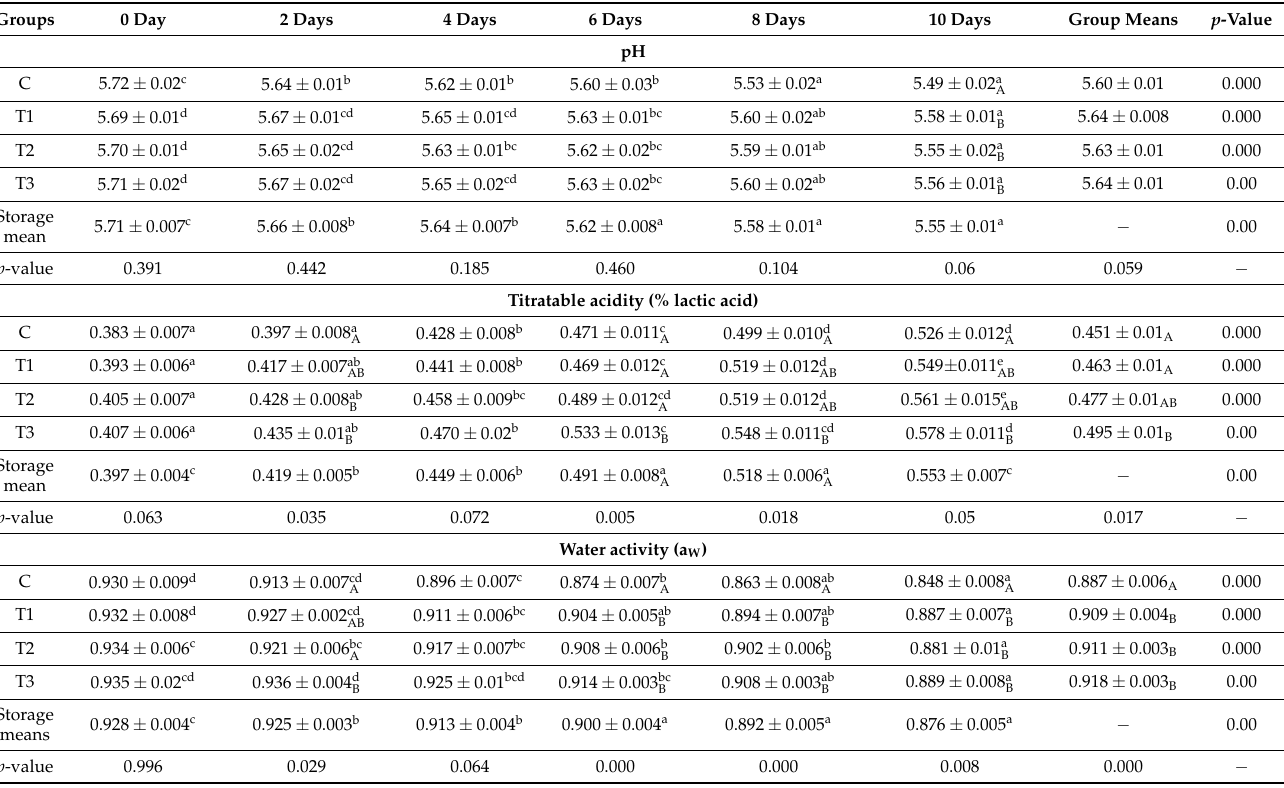
Table 2. Effect of turmeric and aloe vera extract on physico-chemical attributes of goat and buffalo paneer during refrigerated aerobic